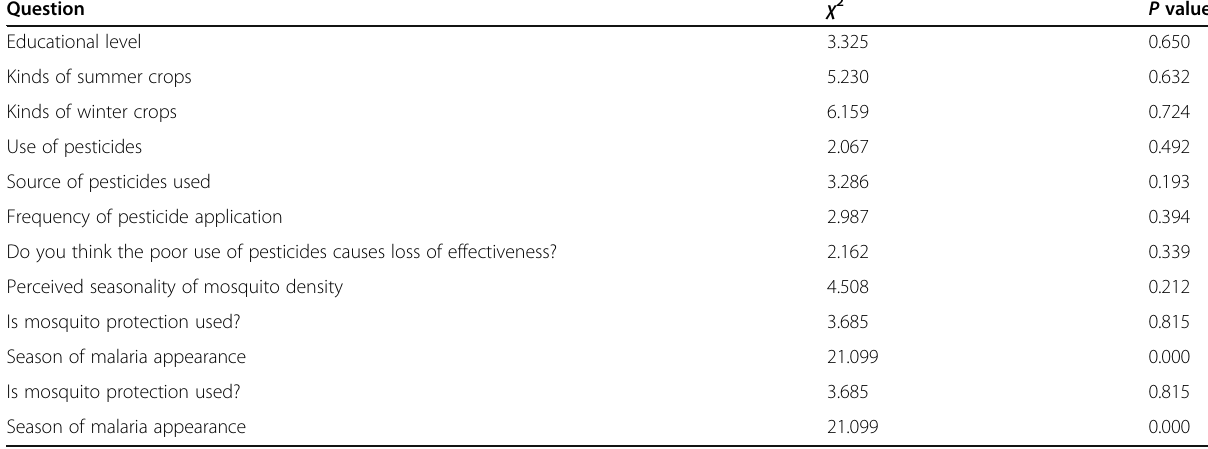
Table 5 Summary of KAP agro-sociological data: comparison of studied variables between urban and rural sites Question χ